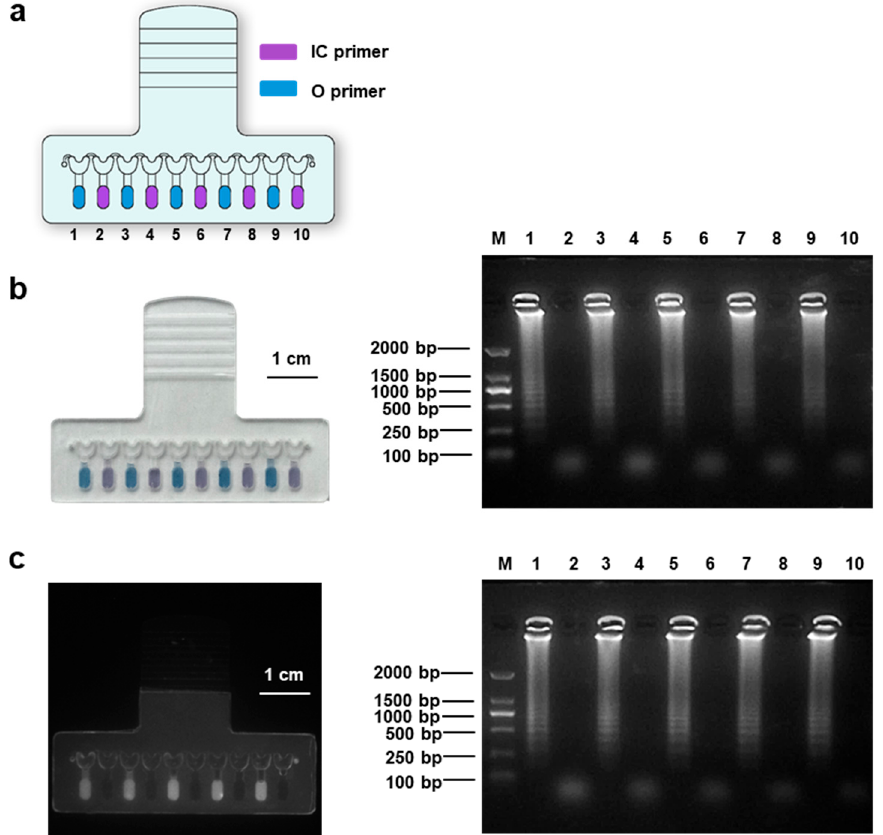
Figure 3. Cross-contamination evaluation based on the EBT-based visible LAMP and EvaGreen-based fluorescent LAMP. ( a ) Schematic diagram of a chip with preloaded primers. The odd-numbered reaction chambers preloaded with primers for the human genome and the even-numbered reaction chambers preloaded with primers for the Orf gene of SARS-CoV-2. ( b ) Photograph of the chip finished with EBT-based visible LAMP amplification (left) and the electrophoretic result of the amplicons (right). The blue color indicates a positive result and the purple color indicates a negative result. ( c ) Photograph of the chip finished with EvaGreen-based fluorescent LAMP amplification (left) under UV and the electrophoretic result of the amplicons